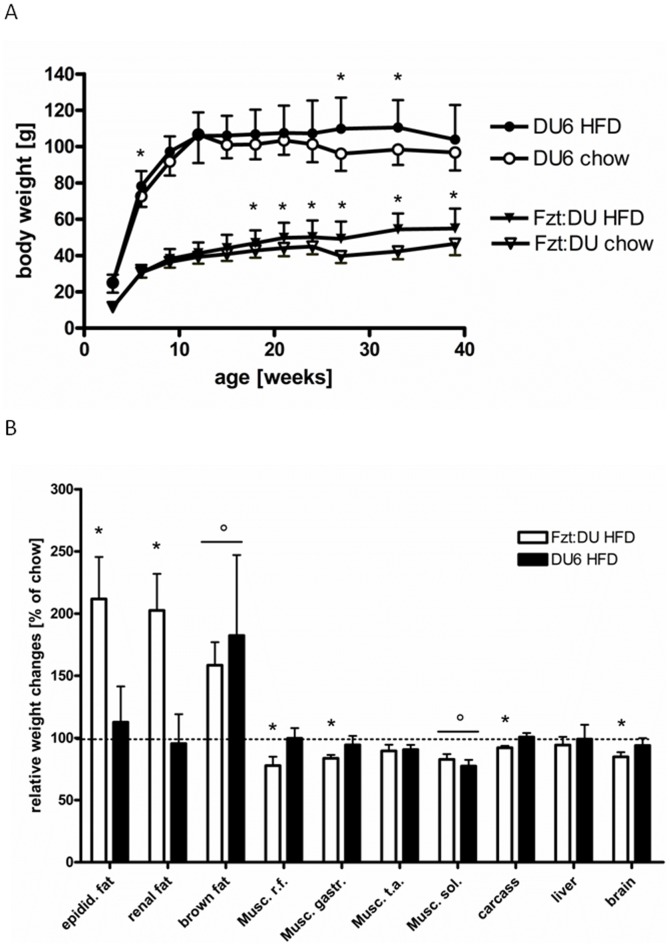
Changes in body and organ mass over life-time under chow and HFD.Effects of a HFD on body weight in male mice (Fig. 2A; until week 27: n>14; week 33 and 39: n>7; week 33: P<0.05). Fig 2B: Effects of a HFD on tissues masses in male mice at an age of 39 weeks (n>7; *: significant effect of line*diet P<0.01 vs. chow diet (100%); °: significant effect of diet as a main effect in both lines: P<0.05 (epidid. fat: epididymal fat mass; Musc. r.f.: Musculus rectus femoris, gastr: gastrocnemius, t.a.: tibialis anterior; sol.: soleus).